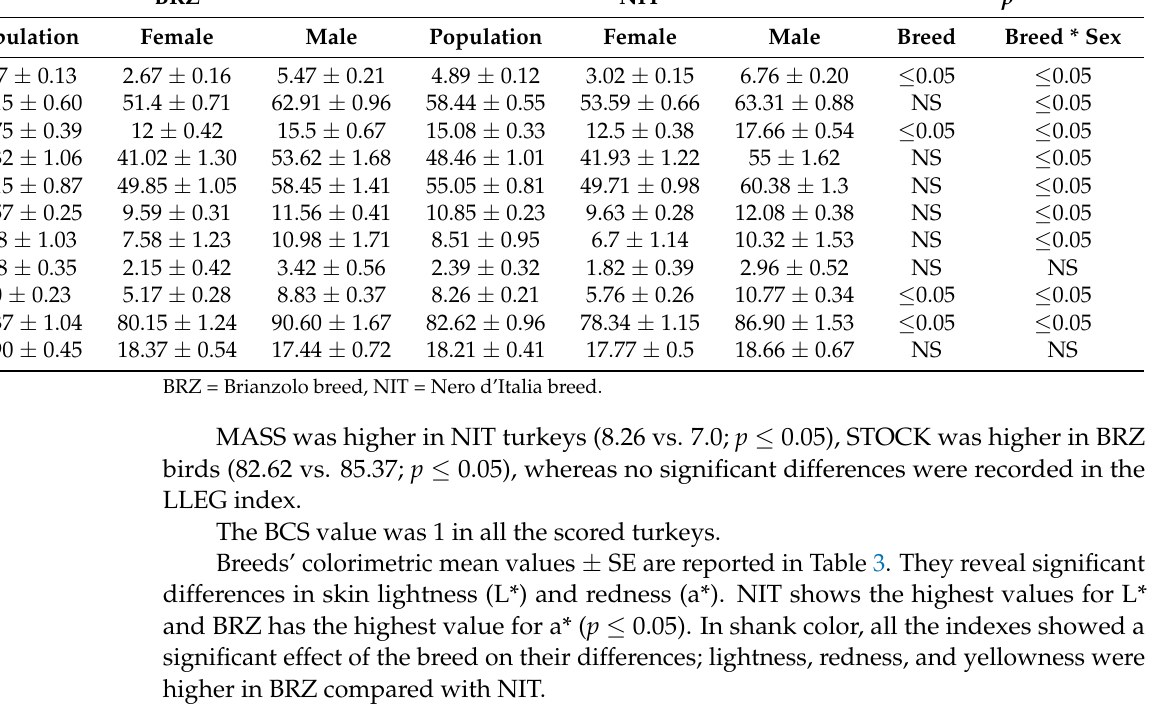
Table 2. Quantitative traits: live weight (LW; kg), total body length (BL; cm), keel length (KL; cm), chest circumference (CC; cm), wingspan (WS; cm), shank length (SL; cm), shank diameter (SD; mm), shank circumference (SC; cm), massiveness (MASS; index), stockiness (STOCK), long-leggedness (LLEG; index) by breed and breed per sex interaction. Least-square means ± standard error. BRZ NIT